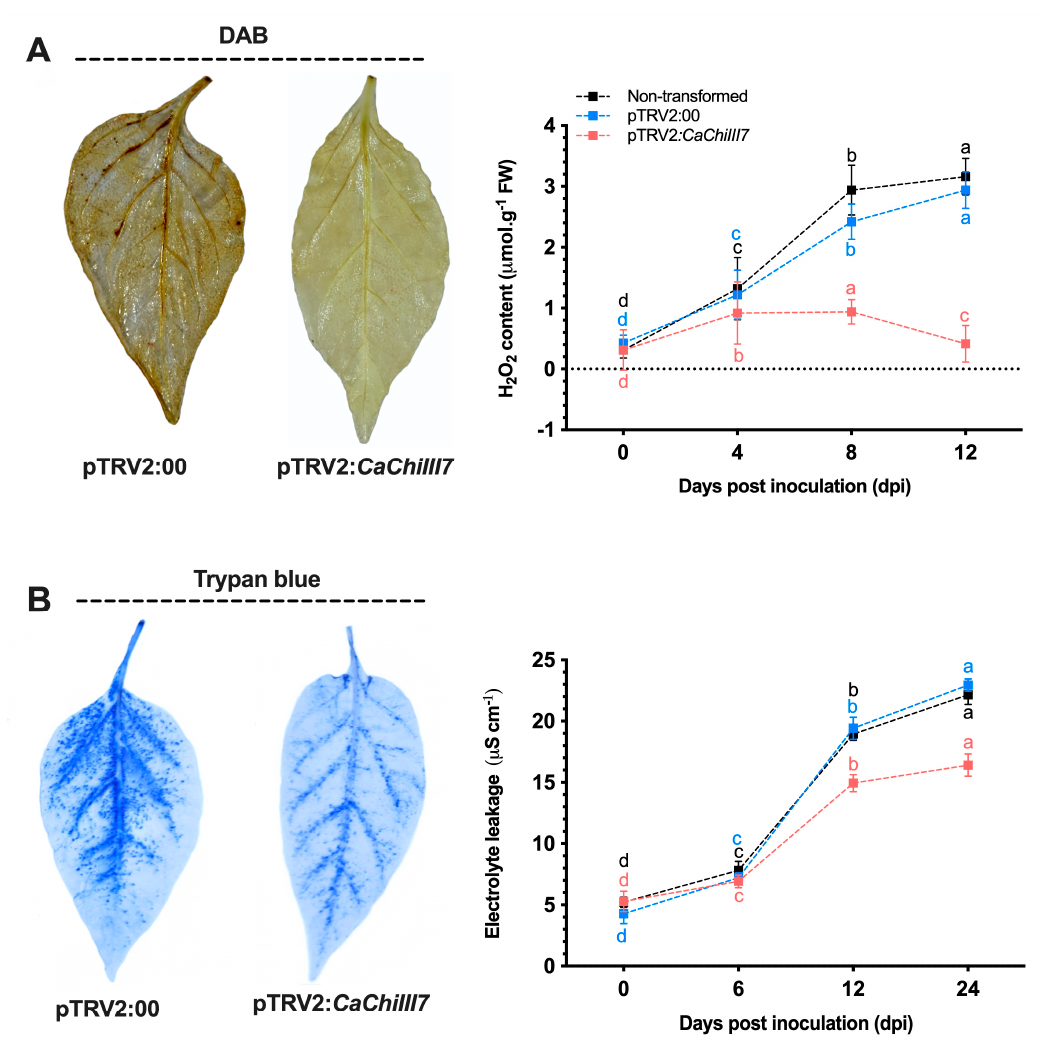
Figure 6. Knockdown of chitinase gene CaChiIII7 reduces the hypersensitive response of pepper plants infected with Colletotrichum acutatum . ( A ) Representative photos show 3,3 ′ -diaminobenzidine (DAB) staining and the plotted results are quantification of H 2 O 2 in CaChiIII7- silenced (pTRV2: CaChiIII7 ) and empty-vector control (pTRV2:00) pepper leaves infected with C. acutatum . ( B ) Photos of trypan blue staining and electrolyte leakage quantification in CaChiIII7- silenced (pTRV2: CaChiIII7 ) and empty-vector control (pTRV2:00) leaves infected with C. acutatum . Data are the means with standard deviations (± SD), and lower-case letters (a–d) indicate significant differences as analyzed by a Duncan’s multiple range (DMR) test ( p < 0.05).